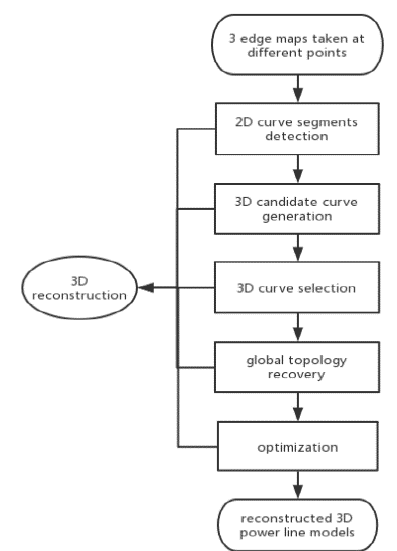
Figure 3. Workflow of 3D wire structure reconstruction procedure